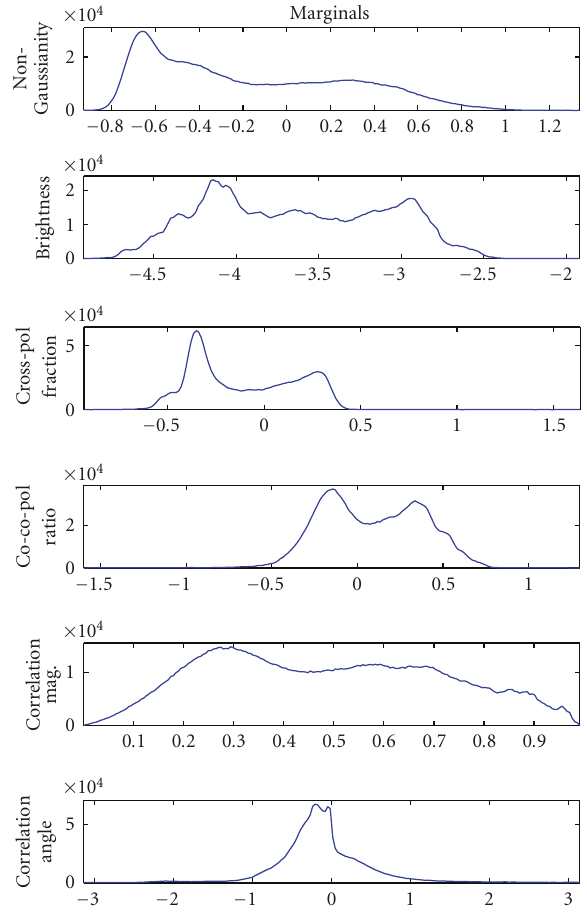
Figure 8: Extracted 6D feature histogram plots. Each feature shows several peaks such that a discrete mixture model may well describe the